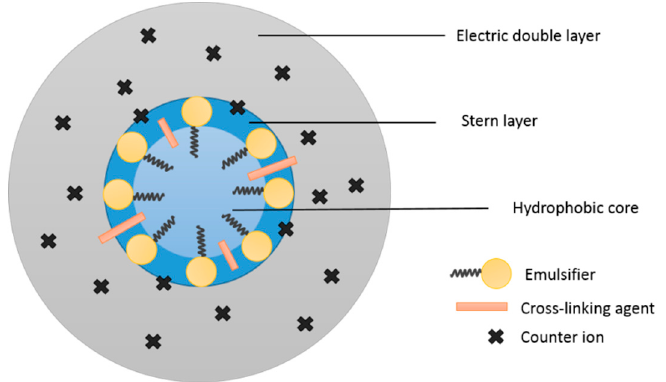
Figure 12. Schematic diagram of crosslinking agent entering emulsion particle.